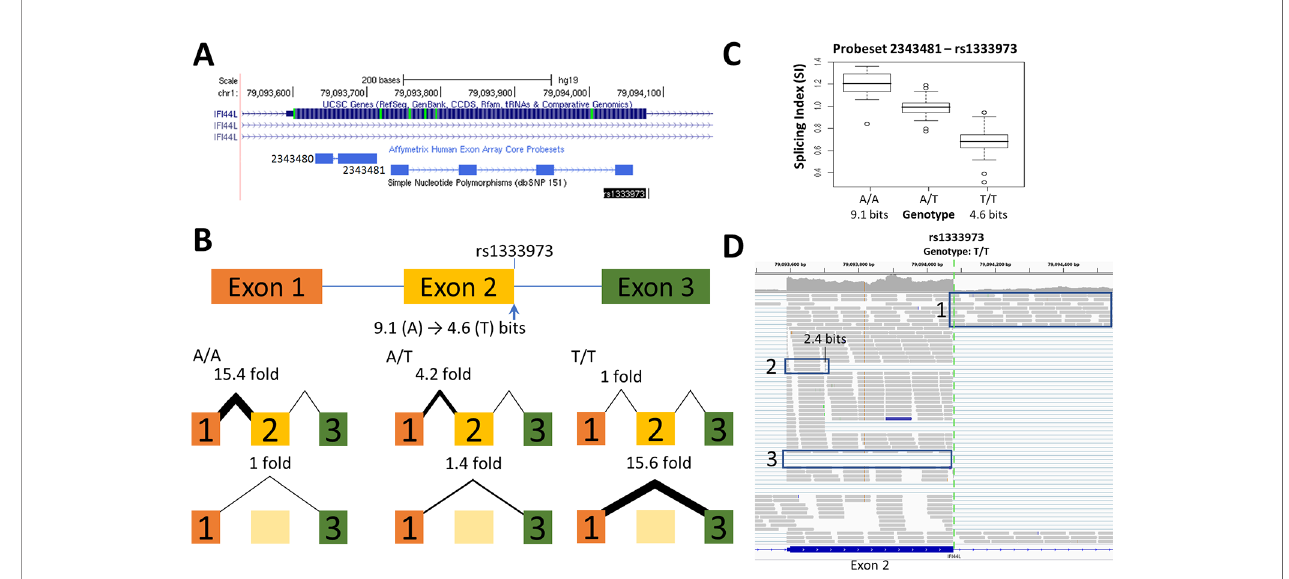
FIGURE 3 | Splicing Impact of rs1333973 ( IFI44L ). (A) The natural donor of IFI44L exon 2 is weakened from 9.1 to 4.6 bits (A > T) by rs1333973, increasing the frequency of exon 2 skipping and other events. (B) By q-RT-PCR, skipping was found to be 15.6-fold higher while normal splicing was 15.4-fold lower in A homozygotes (relative to T homozygotes). (C) Exon microarray data strongly supports the q-RT-PCR fi ndings. (D) ICGC patient DO6354 is homozygous for the T-allele, which resulted in exon 2 skipping [Box 3], failure to recognize the exon 2 donor causing total retention of intron 2 [Box 1], and activation of an upstream exonic 2.4 bit cryptic donor 375 nt from the affected site [Box